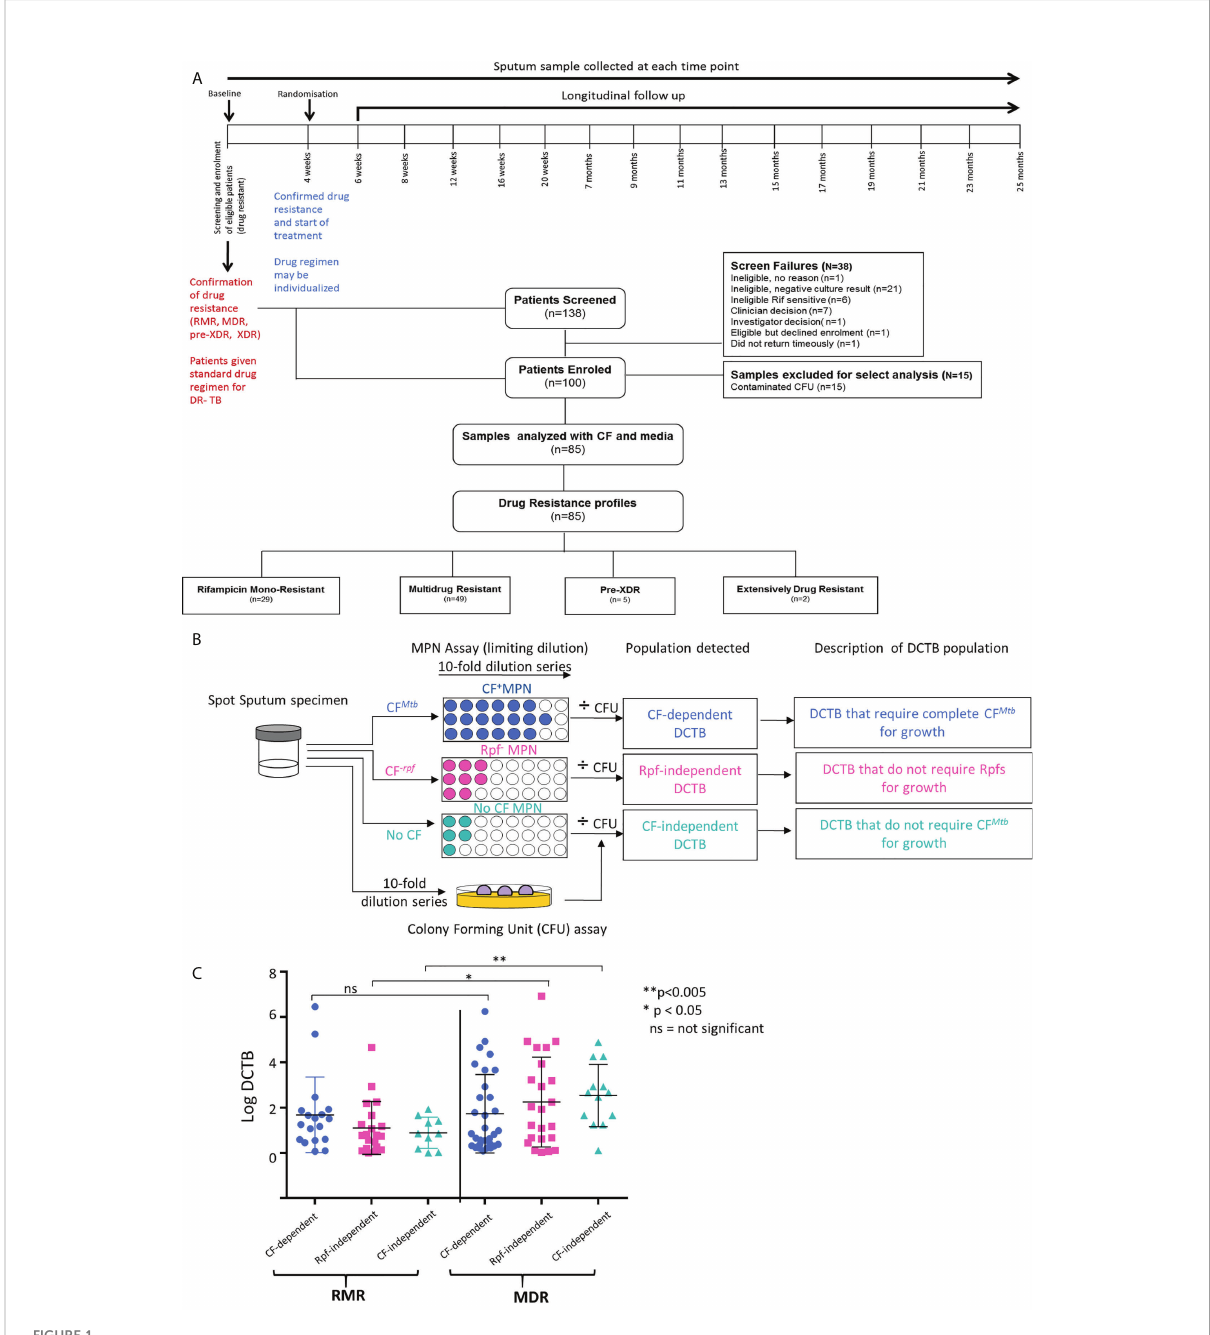
FIGURE 1 Participant disposition fl ow chart and assessment of DCTB in baseline sputum samples. (A) Study timeline and participant disposition fl ow chart for individuals recruited in this study. (B) Flow chart for DCTB assessment of sputum specimens in real time obtained at baseline (screening). Sputum samples were decontaminated and the resulting bacteria assessed by CFU and Most Probable Number (MPN) limiting dilution assays containing CF with and without Rpfs to detect DCTB. To control for the effect of CF in growth stimulation, fresh Middlebrook media was used (No CF MPN). DCTB count was obtained by dividing the MPN values (with or without CF) by CFU counts, the latter depicting conventionally culturable bacteria. (C) Median DCTB counts from different MPN assays and resistance categories (RMR, rifampicin mono-resistant; MDR, multidrug resistant). Values from specimens that had detectable levels of DCTB were used. Error bars depict the interquartile range. An unpaired t-test was used, where *p-value <0.05, **p-value <0.005 and ns, not signi fi